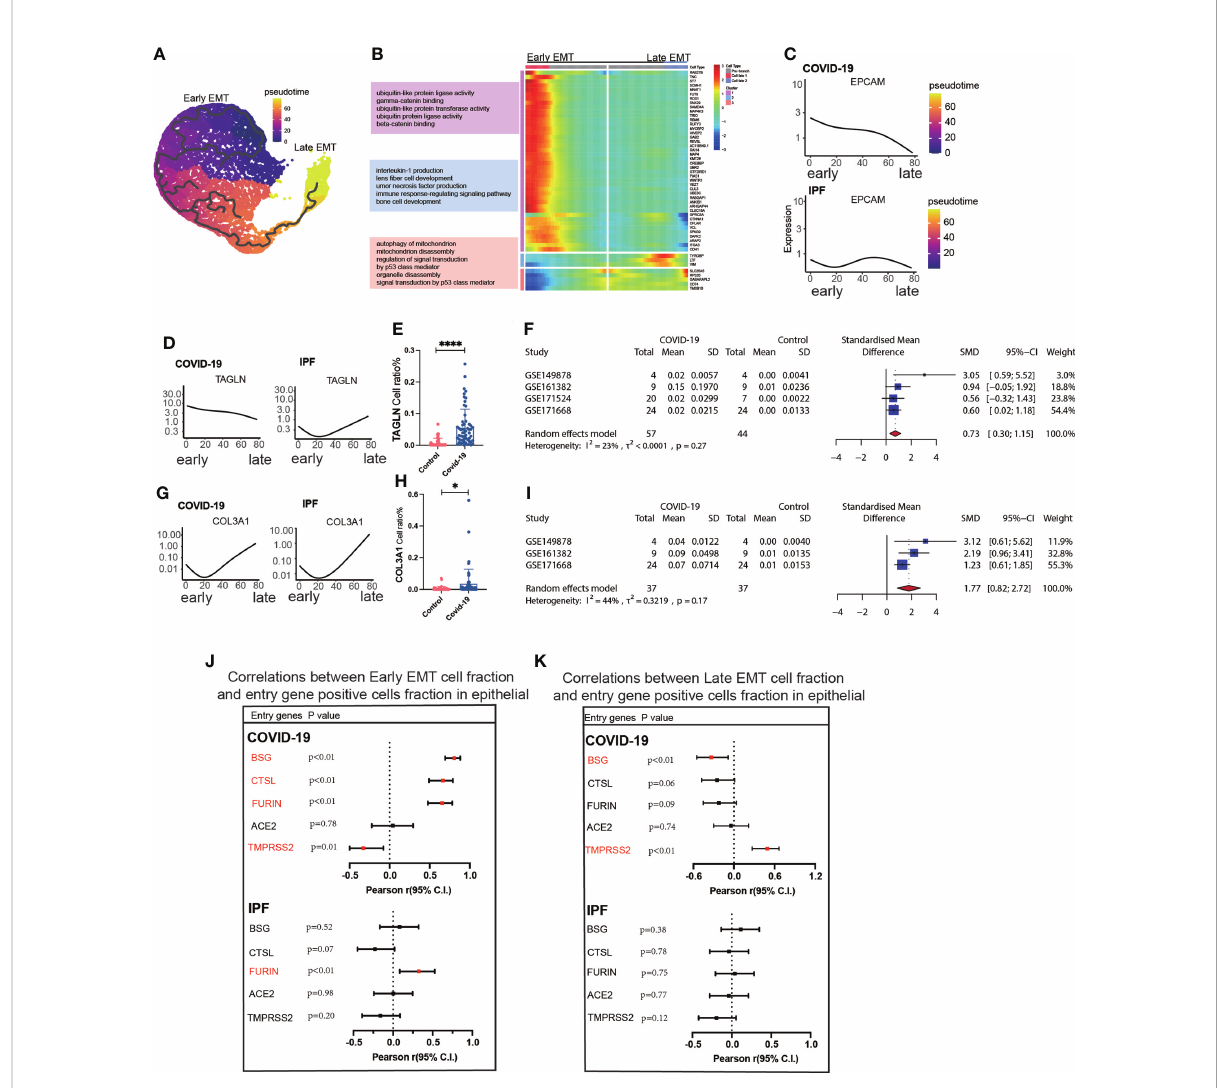
FIGURE 3 Characteristics of early late-stage EMT. (A) Pseudotime projection analysis showing early-stage EMT could evolve to late-stage EMT. (B) Single cell proposed time branch point analysis showing genes with progressively lower and higher expression from Early EMT to Late EMT. Each row of the heat map on the right represents a gene, each column is a proposed time point, and the color represents the average expression value of the gene at the current time point, with the color decreasing from red to blue. The left side shows the signaling pathways that the gene set is enriched. (C) Proposed time traces of individual genes, showing the change in gene expression from the beginning to the end of the proposed time course for epithelial cell marker genes (EPCAM) in COVID-19 and IPF patients, respectively. (D) Time-sensitive trajectories of individual genes, showing the change of Early EMT marker gene (TAGLN) expression from the beginning to the end of the proposed time course in COVID-19 and IPF patients, respectively. (E) TAGLN gene positive epithelial cell ratio is higher in COVID-19 than that in HC. (F) Forest plot of studies with TAGLN gene positive epithelial cell ratio on the COVID-19 and HC, after excluding a study with only one case. the analysis included data from 4 studies with a total of 57 COVID-19 and 44 controls. p value for heterogeneity was 0.27, I2 was 23%. (G) Temporal trajectories of individual genes, showing changes in gene expression of Late EMT marker gene (COL3A1) in COVID-19 and IPF patients by the start to the end of the proposed time course, respectively. (H) COL3A1 gene positive epithelial cell ratio is higher in COVID-19 than that in HC. (I) Forest plot of studies with COL3A1 gene positive epithelial ratio on the COVID-19 and HC, after excluding a study with only one case and a high heterogeneity study. The analysis included data from 3 studies with a total of 37 COVID-19 and37 controls. p value for heterogeneity was 0.17, I 2 was 44%. (J) Forest plot showing the correlation between Early EMT cell fraction and entry gene positive cells fraction in epithelial cells. And entry factors (BSG, FURIN, CTSL) were positively correlated with the expression of Early EMT in COVID-19 (p < 0.05, Pearson ’ s r > 0). TMPRSS2 was negatively correlated with the expression of Early EMT in COVID-19 (p < 0.05, Pearson ’ s r < 0). FURIN was positively correlated with the expression of Early EMT in IPF (p < 0.05, Pearson ’ s r > 0). (K) Forest plot showing the correlation between Late EMT cell fraction and entry gene positive cells fraction in epithelial cells. And entry factor (TMPRSS2) was positively correlated with the expression of Late EMT in COVID-19 (p < 0.05, Pearson ’ s r > 0). BSG was negatively correlated with the expression of Late EMT in COVID-19 (p < 0.05, Pearson ’ s r < 0) *P < 0.05,**** P<